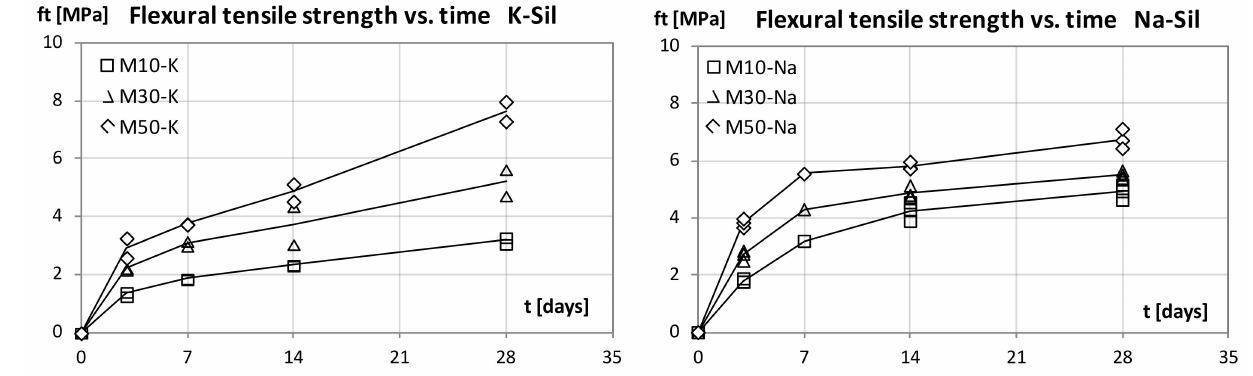
Figure 1. Flexural tensile strength developmnt with curing time, K-Sil and Na-Sil.